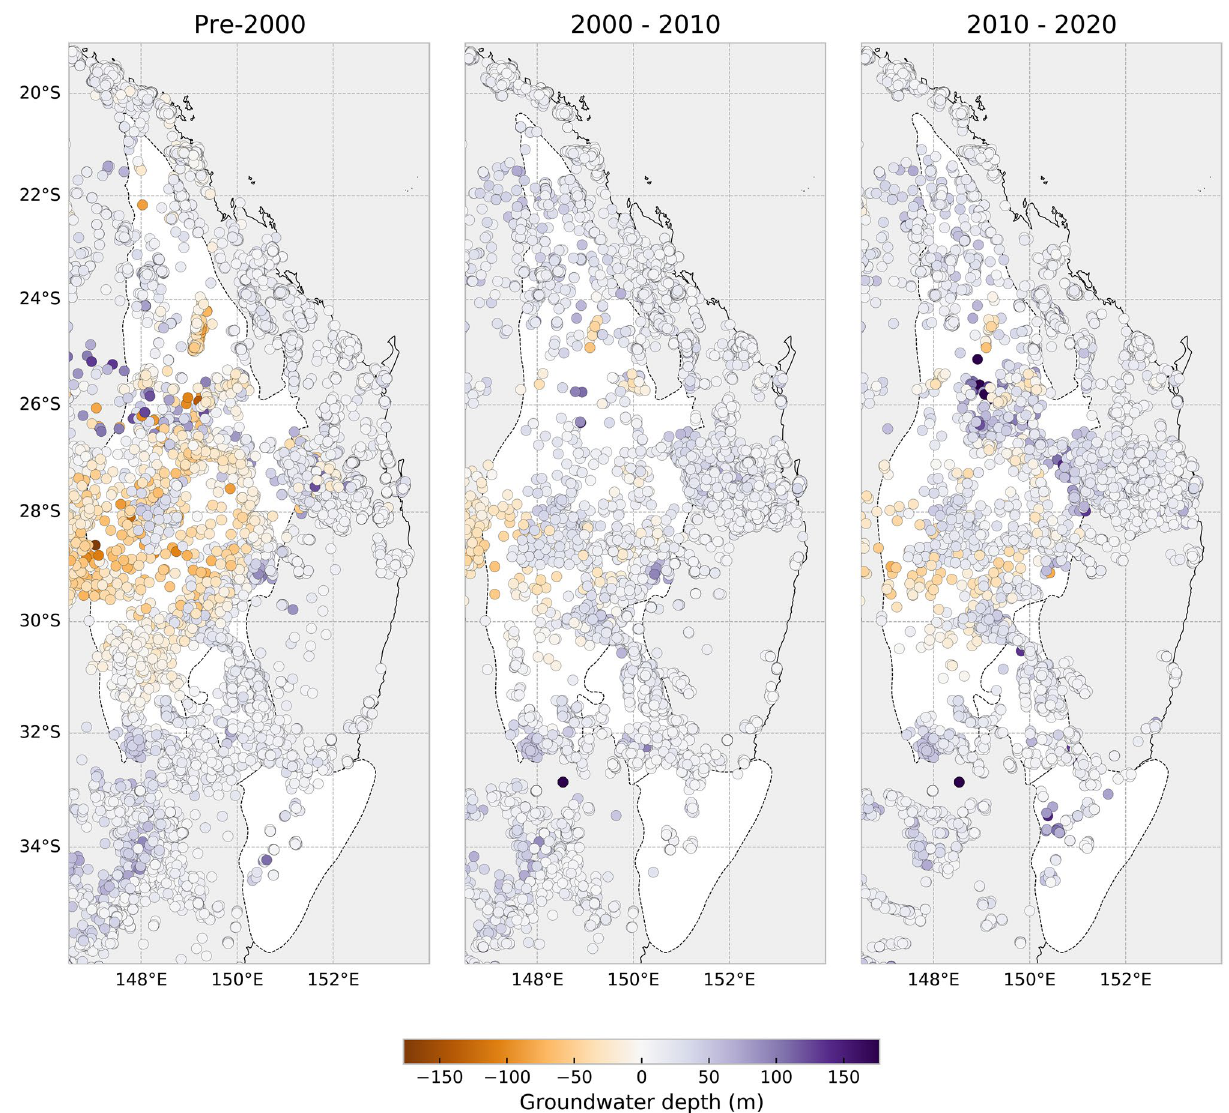
Figure 9. Change in water depth measured in groundwater boreholes pre-2000 to 2020 (negative values indicate artesian pressures translated to meters above the ground surface). These maps were generated from our models using Cartopy 0.19 (https:// scito ols. org. uk/ carto